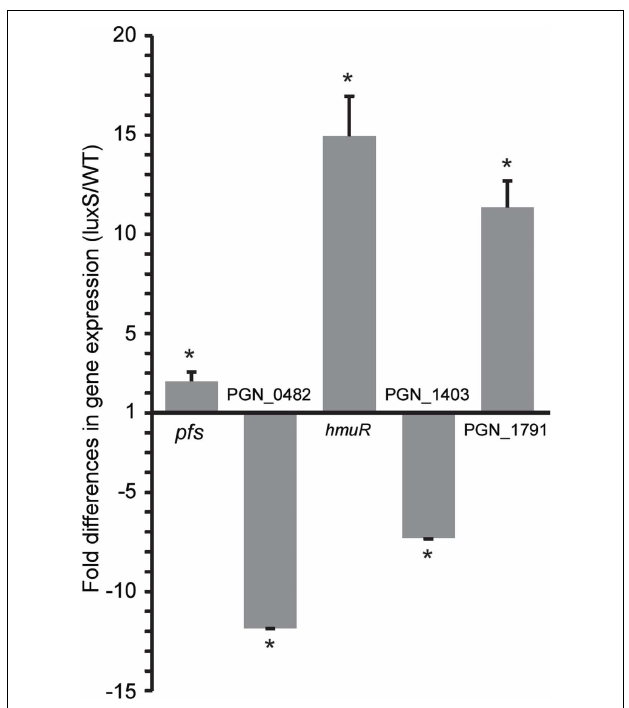
FIGURE 4 | Corroboration of differential gene expression by qRT-PCR. mRNA fromWT and ∆ luxS strains was examined by qRT-PCR. 16S rRNA was used for sample normalization. Asterisk denotes a significant difference at p < 0.0001 (unpaired t -test) in levels of mRNA in isogenic ∆ luxS mutant strain in comparison withWT. Data are shown as means with standard deviations of three biological replicates ( n =